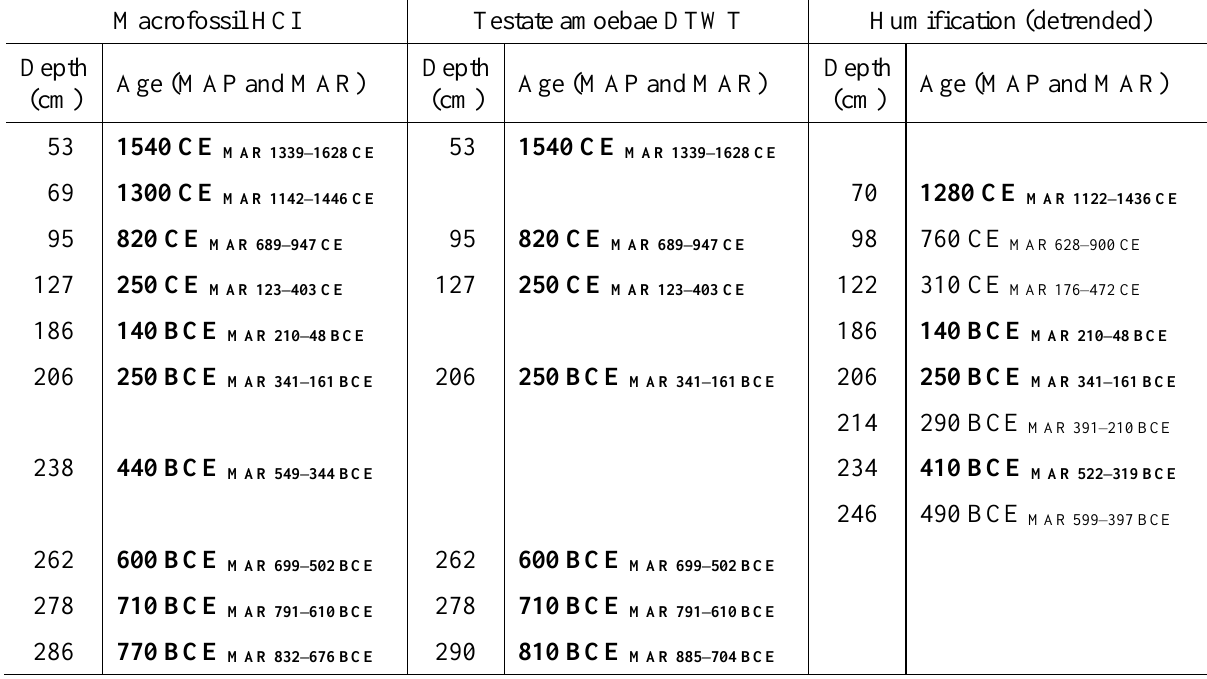
Table 2. Depth (cm), maximum age probabilities (MAP) and modelled age range (MAR) for shifts to higher water tables recorded by each proxy from Killorn Moss. Bold typeface is used for events recorded by two or more of the three